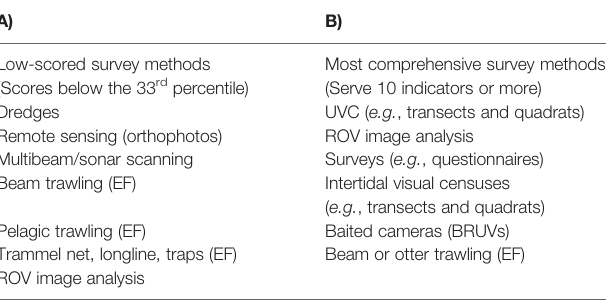
TABLE 5 | Indicator ’ s survey methods A) with low scoring – sorted according to their scores in ascending order (data from Workshop II) and B) the most comprehensive – sorted according to the number of indicators they serve in descending order (data from Workshop